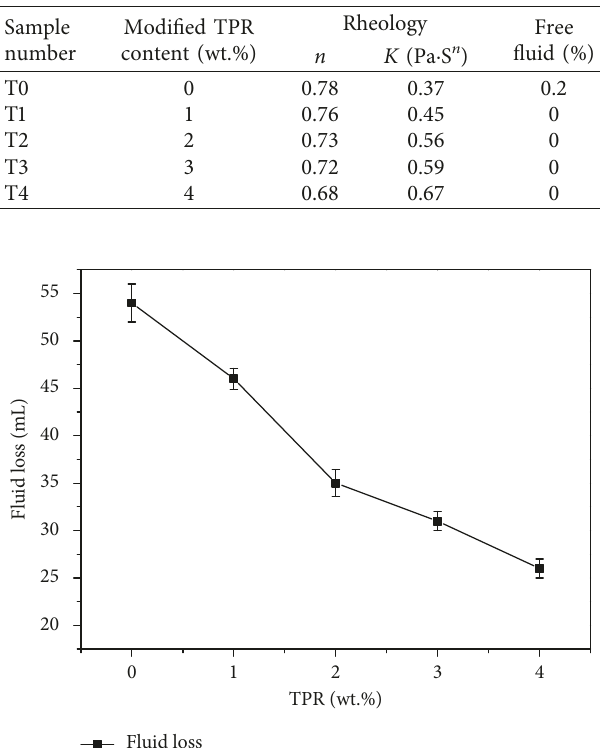
Figure 6: Water loss of cement slurry with different modified TPR